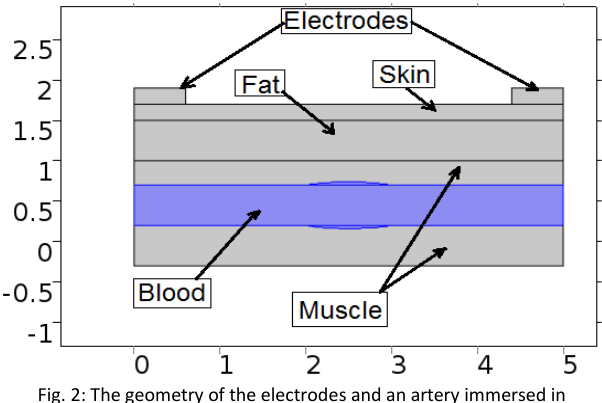
Fig. 2: The geometry of the electrodes and an artery immersed in muscle and fat layers and covered by a skin layer. All dimensions in cm [10].